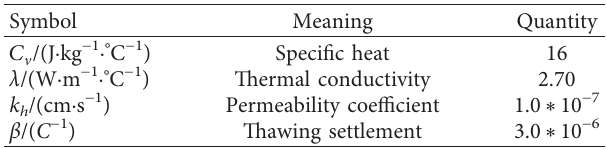
Table 2: The thermal-hydraulic parameter of soil and water.